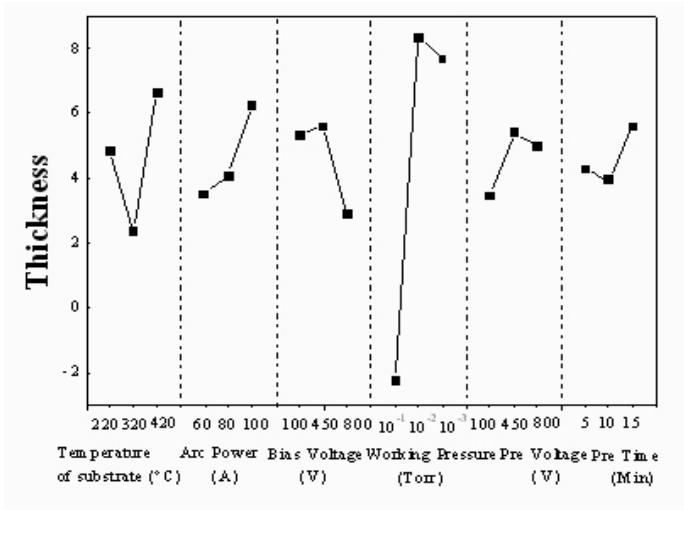
Figure 3. Response graph for the six factors vs.